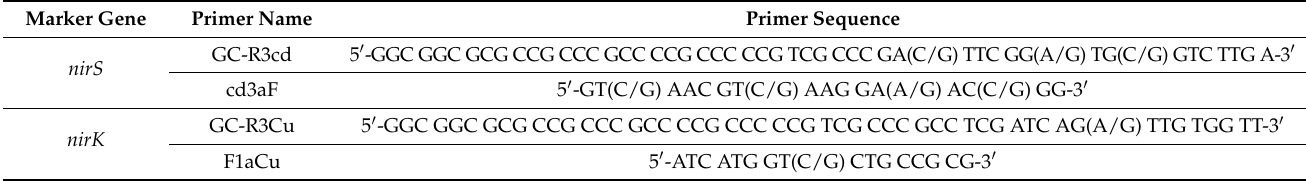
Table 2. PCR primers used to amplify fragments of nirS and nirK genes (based on [27] and [28], respectively). Marker